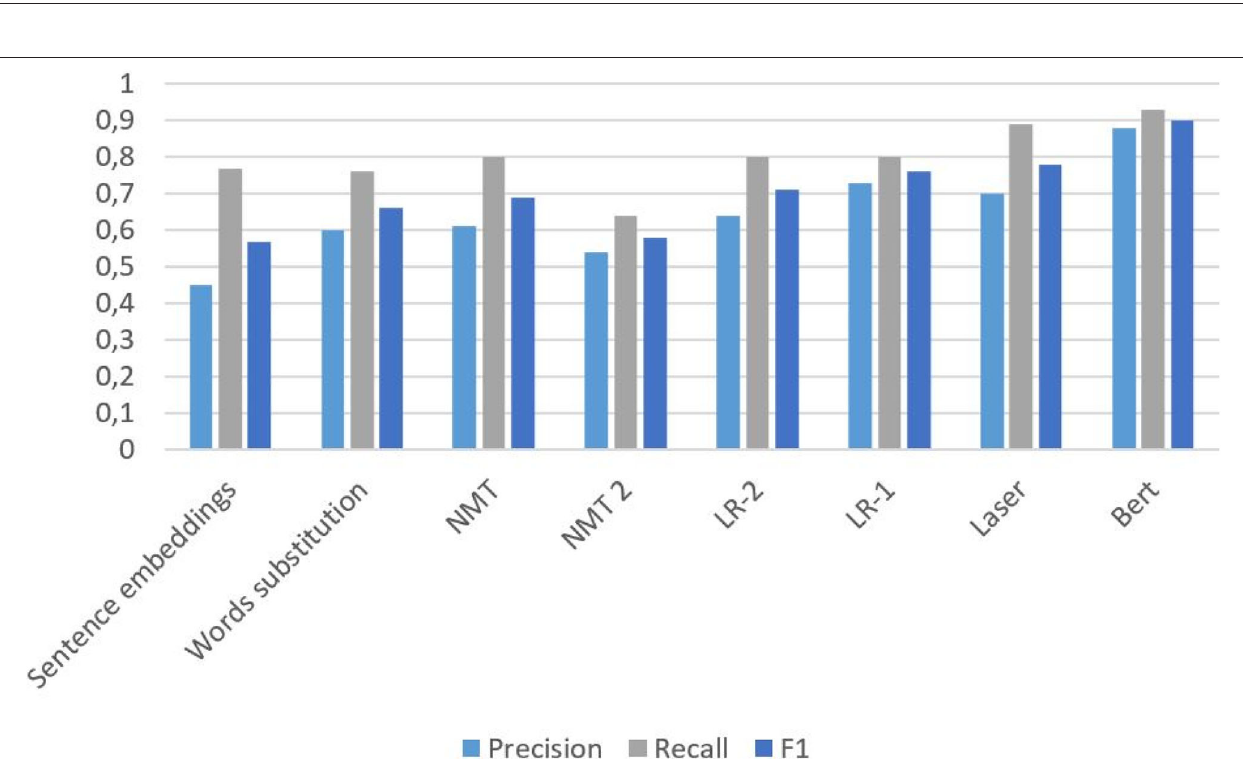
FIGURE 3 | Results of methods from article (Zubarev and Sochenkov, 2019) with Negative-4.